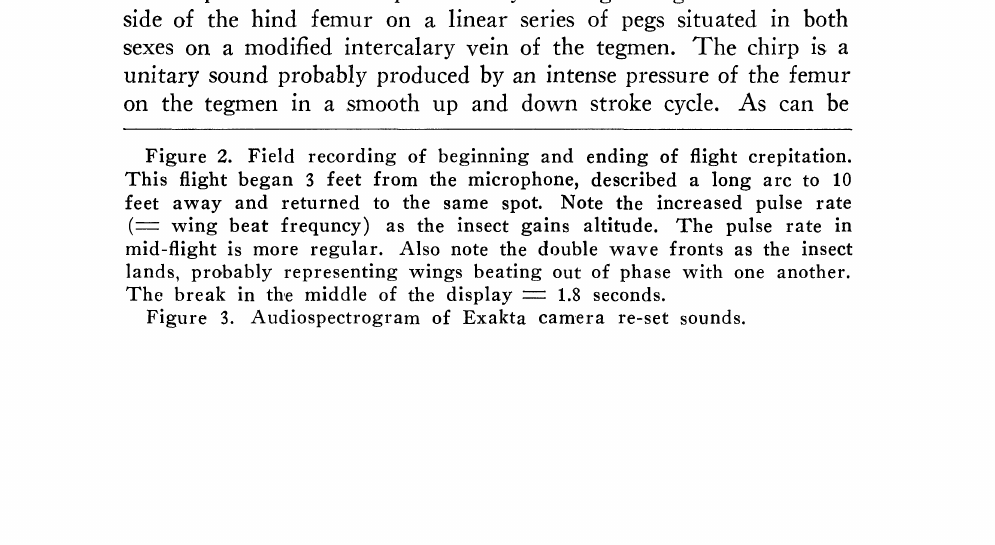
Figure 2. Field recording of beginning and ending of flight crepitation. This flight began feet from the microphone, described a long arc to 10 feet away and returned to the same spot. Note the increased pulse rate (- wing beat requncy) as the insect gains altitude. The pulse rate in mid-flight is more regular. Also note the double wave fronts as the insect lands, probably representing wings beating out of phase with one another. The break in th,e middle of the display--- 1.8 seconds. Figure 3. Audiospectrogram of Exakta camera re-set